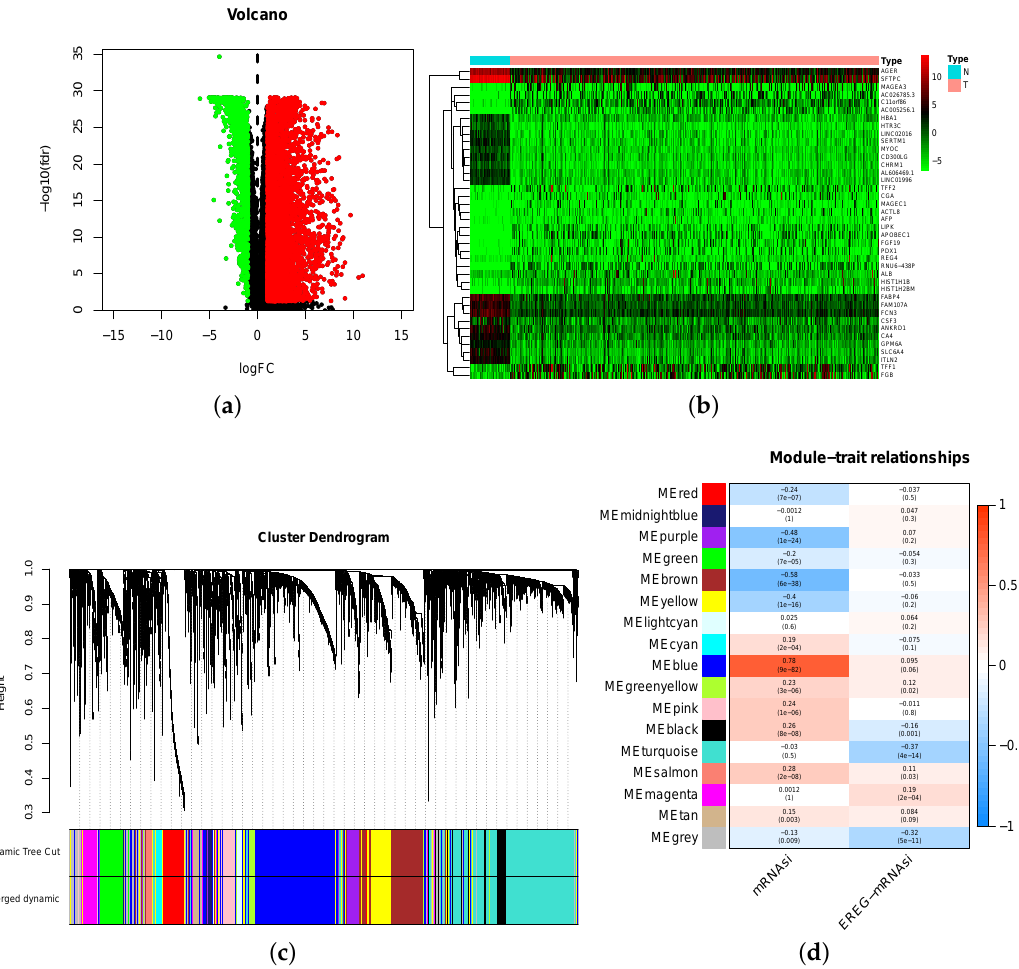
Figure 4. The mRNAsi index associated weighted gene co-expression network analysis (WGCNA) of lung adenocarcinoma. ( a , b ) differentially expressed genes; green indicates downregulated genes and red indicates upregulated genes. The Wilcox test shows that there are 500 genes downregulated and 2876 genes upregulated, false discovery rate (FDR) < 0.05 and |logFC| > 1 are considered meaningful. ( c ) The samples with a deflection of gene expression were cut off, and the appropriate power value was determined (=4) as a soft threshold, taking both the scale-free correlation coefficient and mean connectivity into consideration. Then, a co-expression module in LUAD was identified using the power value (Appendix A). Finally, the dendrogram was drawn with branches of the cluster corresponding to the 17 different gene modules, and modules with a standard of the minimum size of 50 genes for module merging were screened out; ( d ) the correlation between the gene modules and clinical traits, including both mRNAsi and EREG-mRNAsi. The correlation coefficient in the heat-map is equal to the correlation between each gene module and the clinical traits, which decreased from red to blue, also annotated with the corresponding p